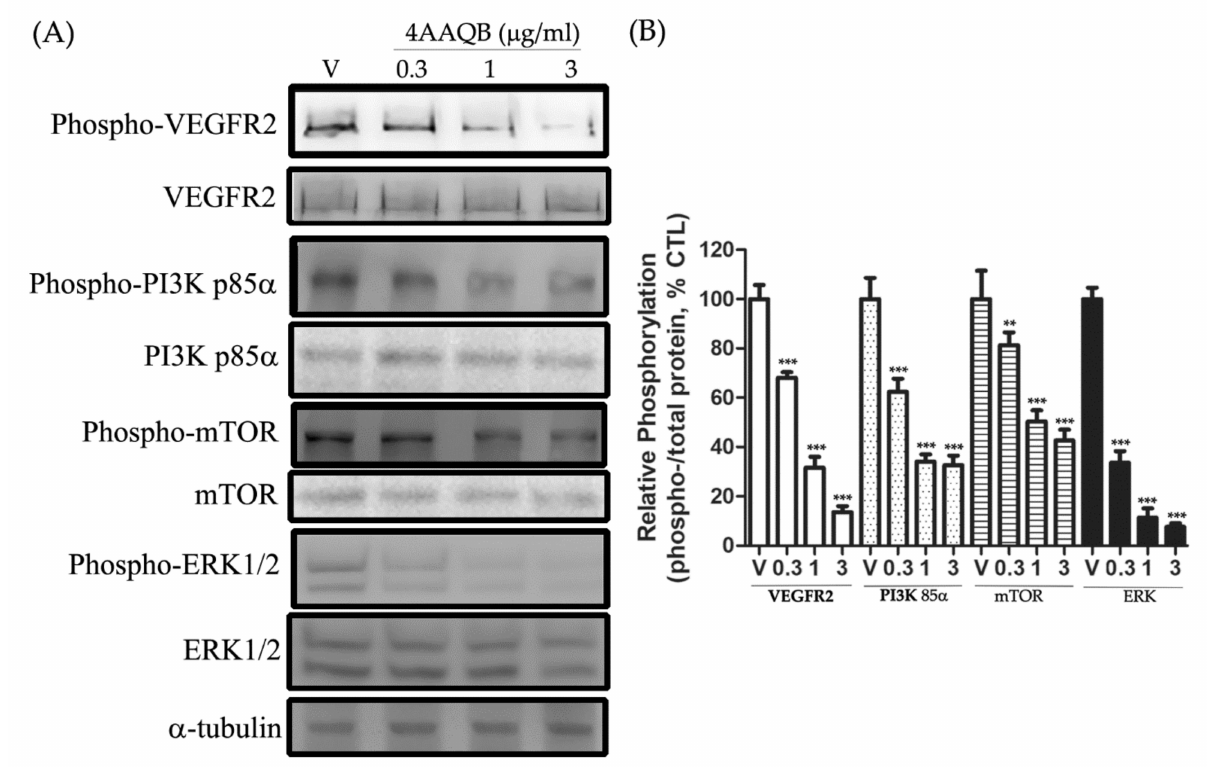
Figure 7. The effect of 4AAQB on VEGF-R2/PI3 p85 α /mTOR/ERK pathways: ( A ) The inhibition effect of various concentrations of 4AAQB on the VEGFR2, PI3K, mTOR, and ERK pathways in HUVEC were detected by Western blotting; ( B ) relative phosphorylation of protein is presented as mean density for the ratio between phosphorylated protein and total protein as determined by ImageJ and the data are represented as means ± SEM ( n = 5). ** p < 0.01 and *** p < 0.001 compared to the vehicle (V)